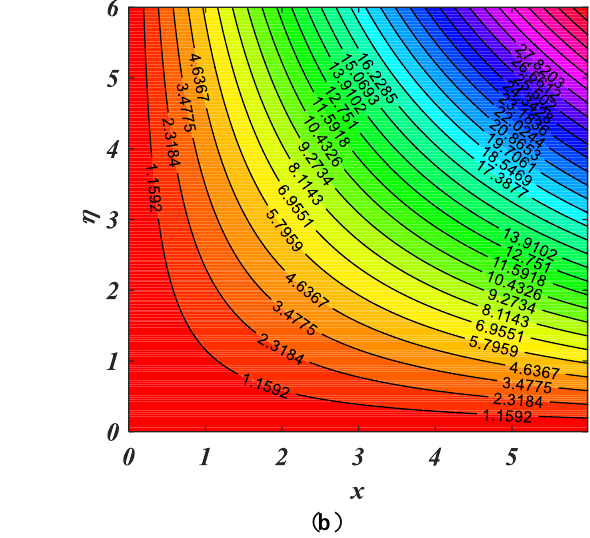
Figure 13. ( a , b ) Streamline pattern for the numerous values of ( a ) 𝛼 = 1.5 and ( b ) 𝛽 = 2.0 .